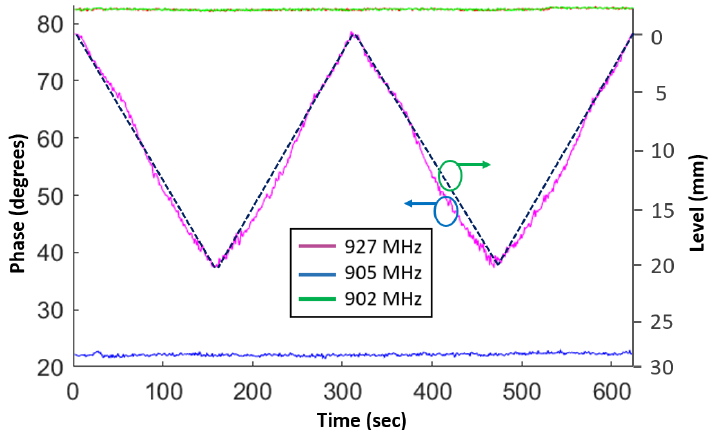
Figure 6. Repeatability test results of the proposed sensor.